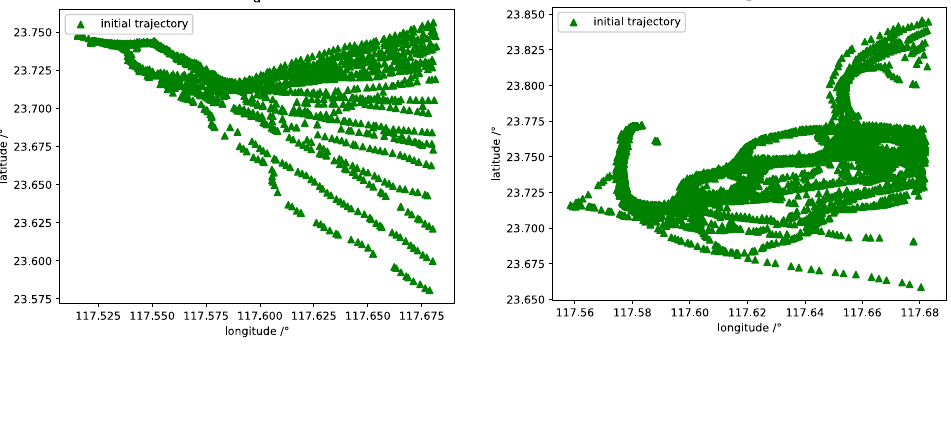
between S 2 is 3 1